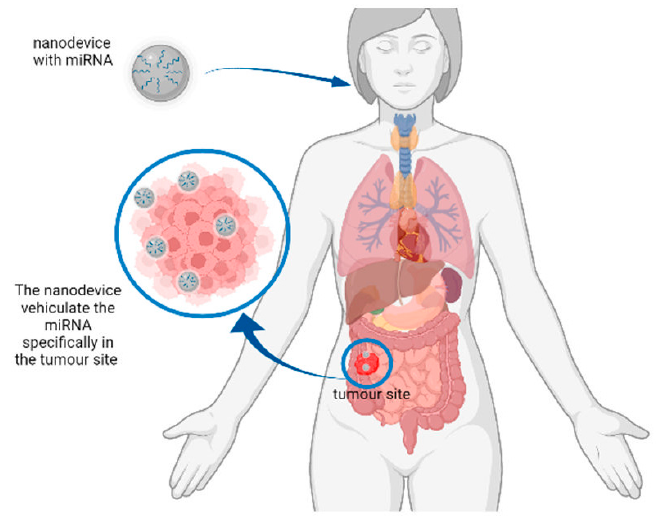
Figure 2. Representation of a hypothetical mechanism of action of nanodevices for miRNA delivery. The nanodevice can deliver the miRNA of interest to the tumour site to reduce the expression of tumour-related genes.